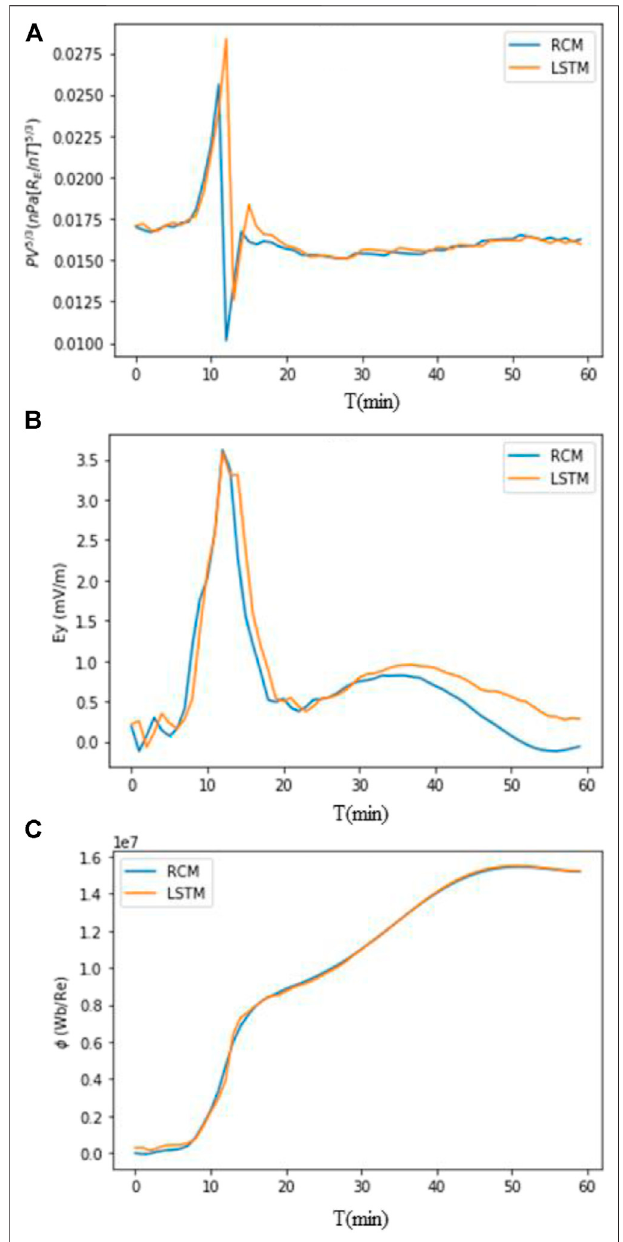
FIGURE4| Single-pointcomparisonoftheRCMsinglebubblerunwiththe LSTM-based RNN model at X (cid:1) − 9.9 and Y (cid:1) − 1.1; (A) PV 5/3 in nPa [R e /nT] 5/3 ; (B) E y in mV/m; and (C) ϕ in Wb/R e